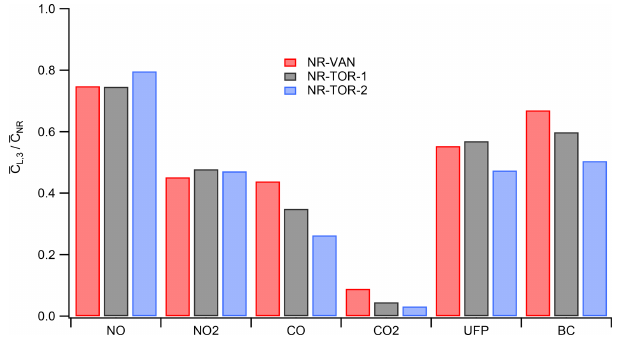
Figure 8. Average fraction of near-road measurements attributed to local sources, as determined by method 3, for each near-road moni- toring